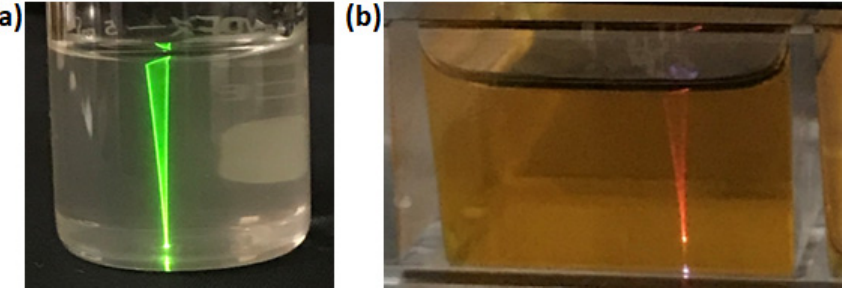
Figure 5. Resin formulation: ( a ) without; ( b ) with 0.05 wt% Eosin Y and 2.5 wt% TEA upon excitation with a 980 nm laser.